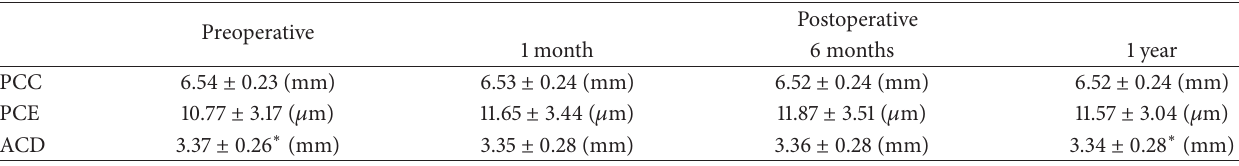
Table 1: Posterior corneal curvature (PCC), posterior corneal elevation (PCE), and anterior chamber depth (ACD) before FS-LASIK and 1 month, 6 months, and one year